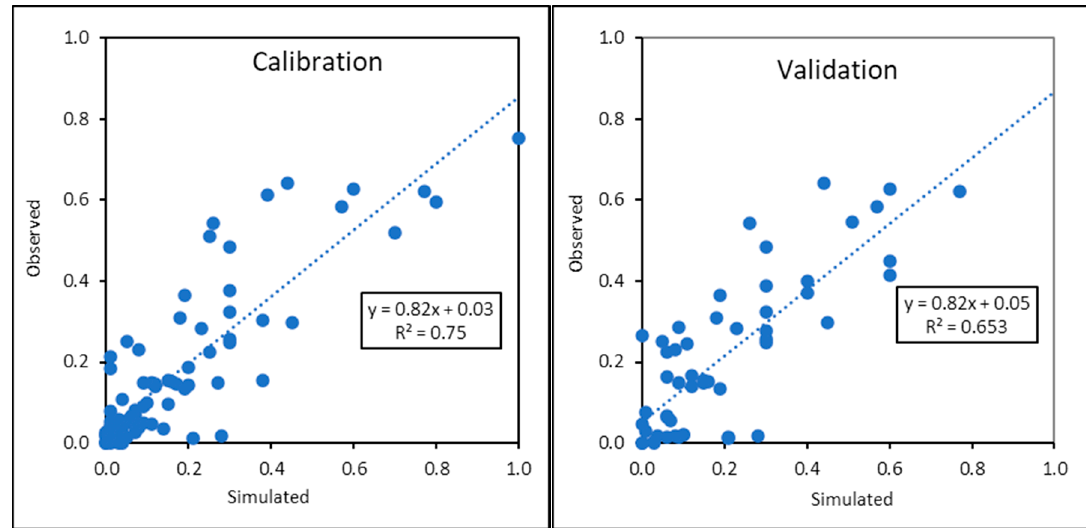
Figure 3. Observed and DRAINMOD-simulated daily NO 3 -N (kg/ha) from tile outflow at Londesborough field site during calibration (left) and validation (right) periods.